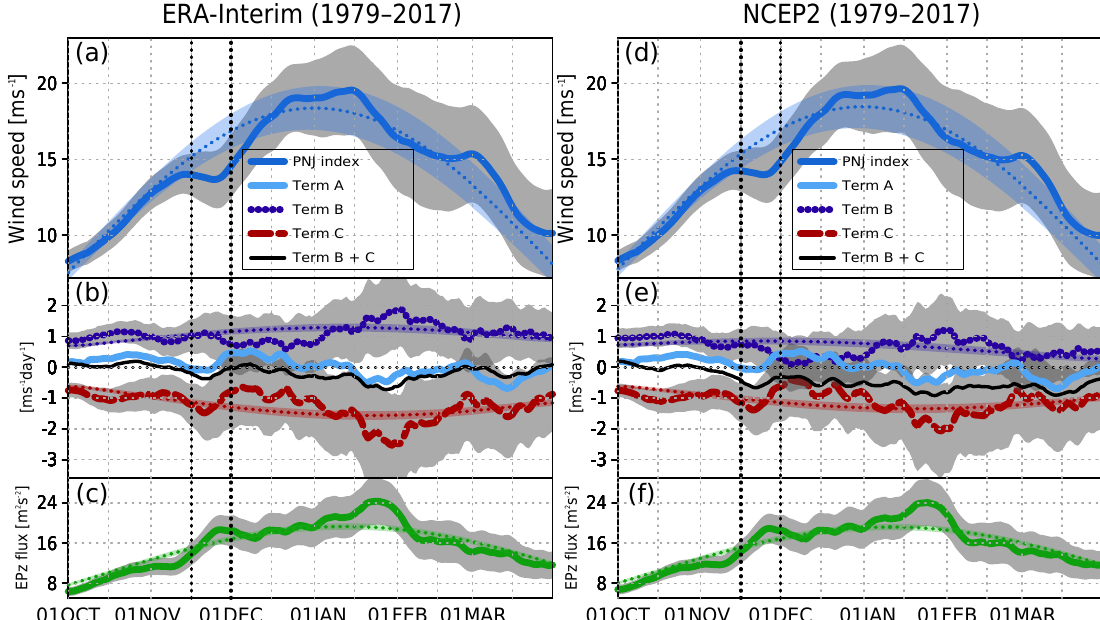
Figure A1. Same as Fig. 2, but (a) – (c) for ERA-Interim and (d) – (f) for